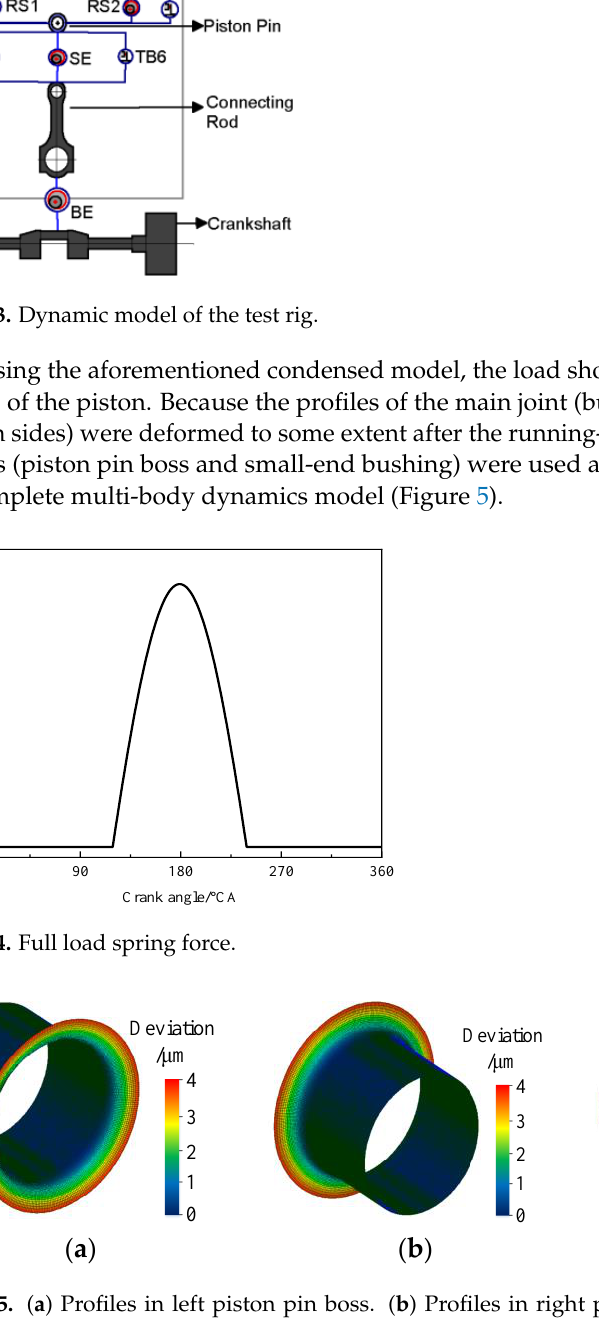
Figure 5. ( a ) Profiles in left piston pin boss. ( b ) Profiles in right piston pin boss. ( c ) Profiles in small-end bushing.